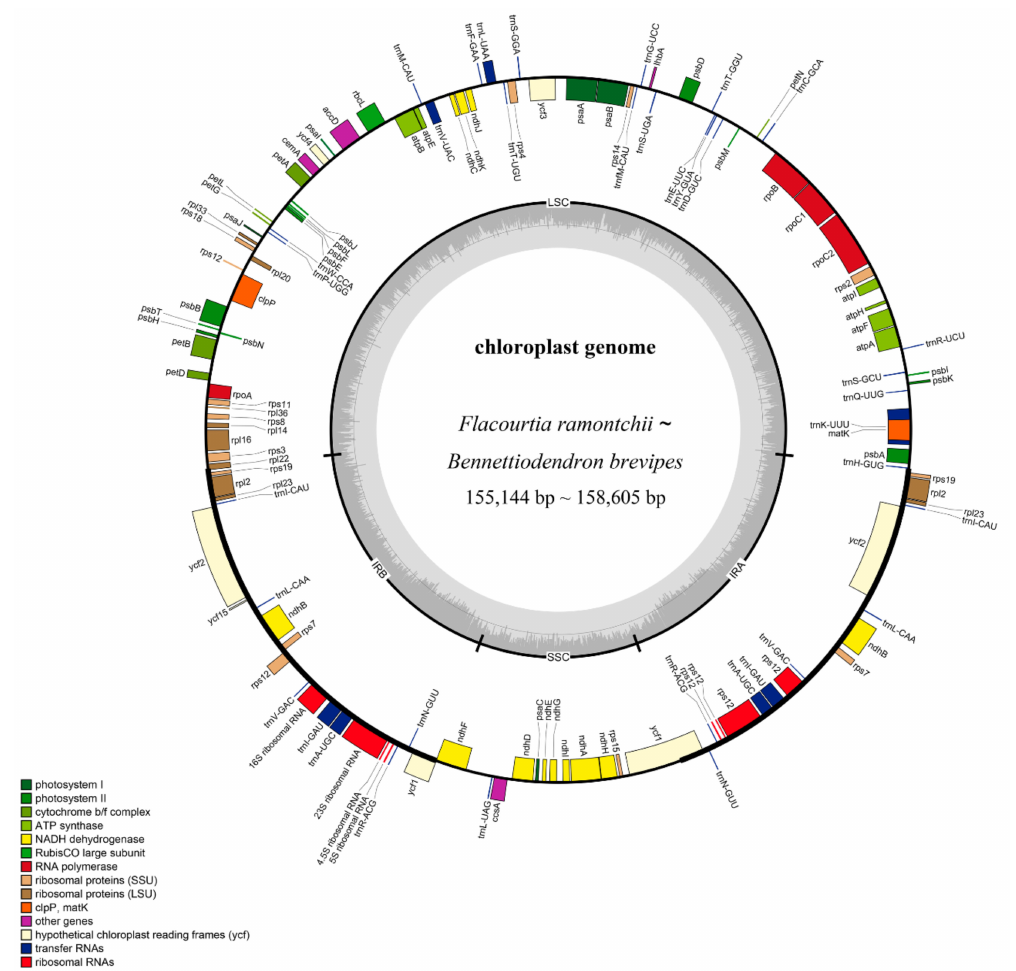
Figure 1. Gene map of 20 Salicaceae s.l. chloroplast genomes. Functional categories of genes are color-coded. Genes inside the circle are transcribed clockwise and genes outside the circle are transcribed counter clockwise. The dashed area in the inner circle indicates the GC content of the plastid